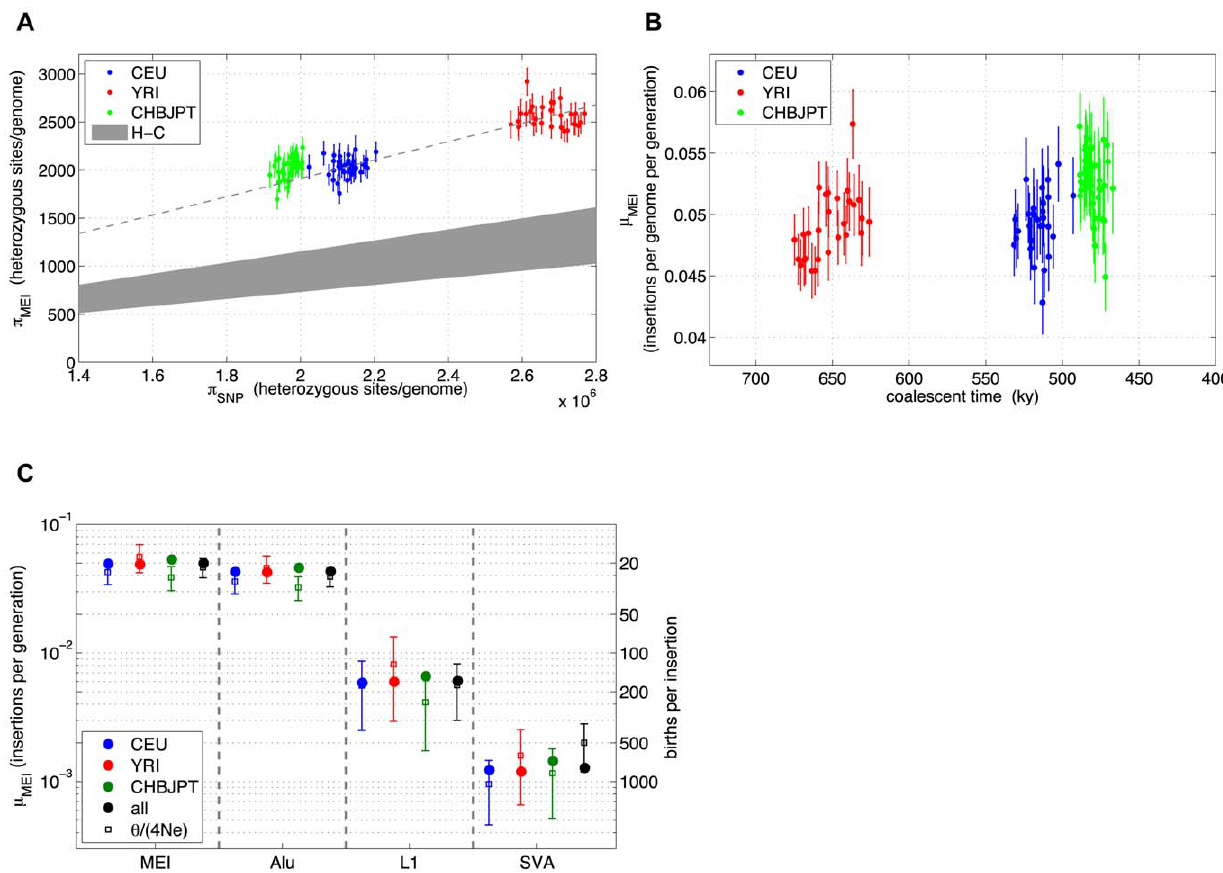
Figure 7. MEI and SNP heterozygosity in low coverage samples. a) MEI vs. SNP heterozygosity scatterplot ( p MEI vs. p SNP ): The dashed line is a linear model constrained to pass through the centroid of the YRI (red) samples and the origin. The gray region represents an extrapolation from human-chimpanzee (H-C) MEI and SNP differences between the respective genome assemblies. b) Averaged population m MEI vs. coalescent time scaled to thousands of years, assuming that SNP mutation rate is a steady clock ( m SNP , 1.8 6 10 2 8 mutations per site per generation). c) MEI mutation rates based on heterozygosity (solid circles) and based on allele frequency fits (vertical error bars) for population groups (CEU: blue, YRI: red, CHBJPT: green, all three: black) and estimated separately for element families (all families combined: MEI, Alu, L1, and SVA). Error bars are statistical only.